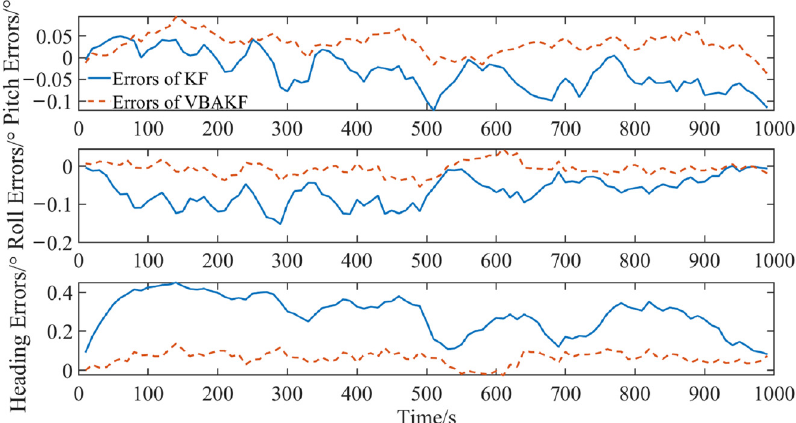
Figure 3. Comparison of filtering results when the measured noise covariance is an unknown time-varying random quantity.